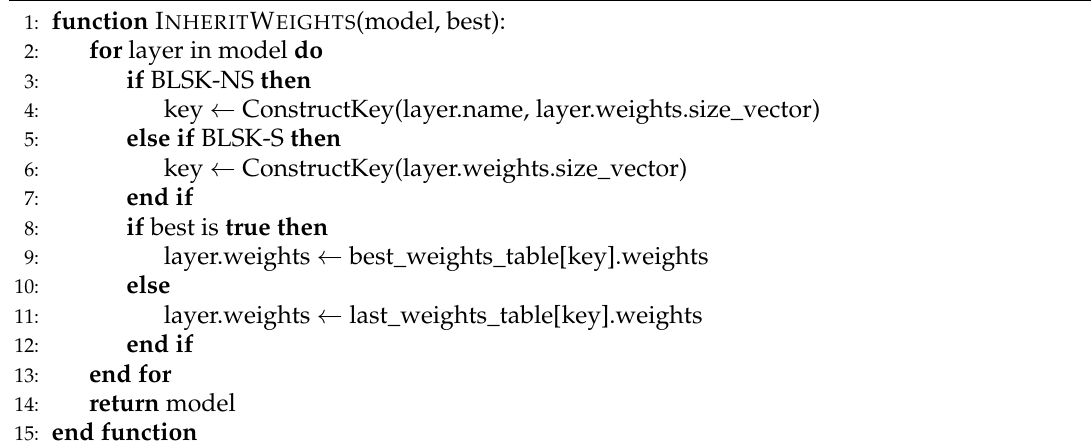
Algorithm 3 Pseudocode to inherit weights for a partially trained CNN model from centralised lookup